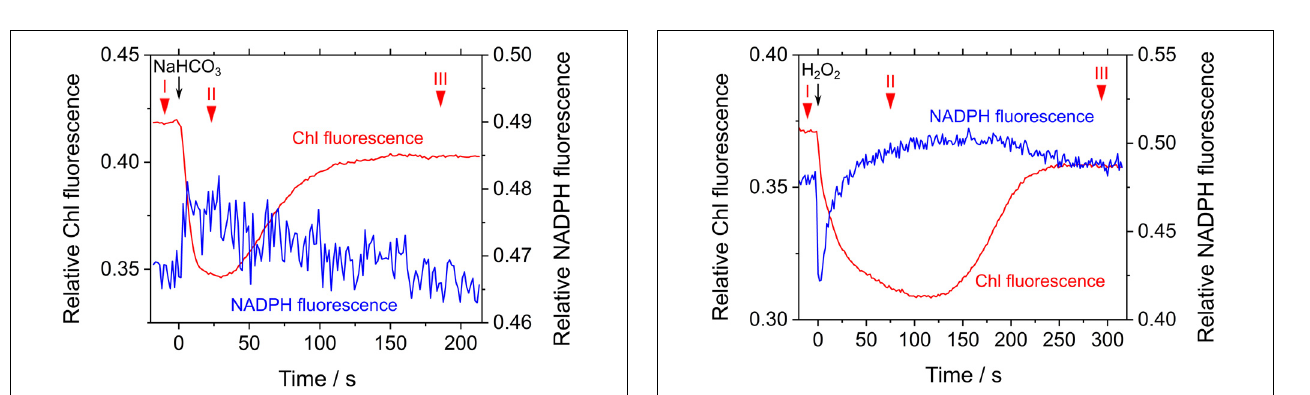
FIGURE 5 | Effects of exogenous H 2 O 2 on relative chlorophyll (Chl, red line) and NADPH (blue line) fluorescence in phase β in Synechococcus elongatus PCC 7942. Black arrow shows the point in time at which H 2 O 2 (50 µ M) was added. Catalase activity of the cyanobacterial cells was inhibited by adding hydroxylamine (25 µ M). The incident quantum yield of PSII, Y(II), was measured at the points in time indicated by red inverted triangles: I, 0.027 ± 0.004; II, 0.120 ± 0.011; and III, 0.027 ± 0.007 (mean ± standard deviation, n = 3). The line graphs show the representative results of three experiments (technical